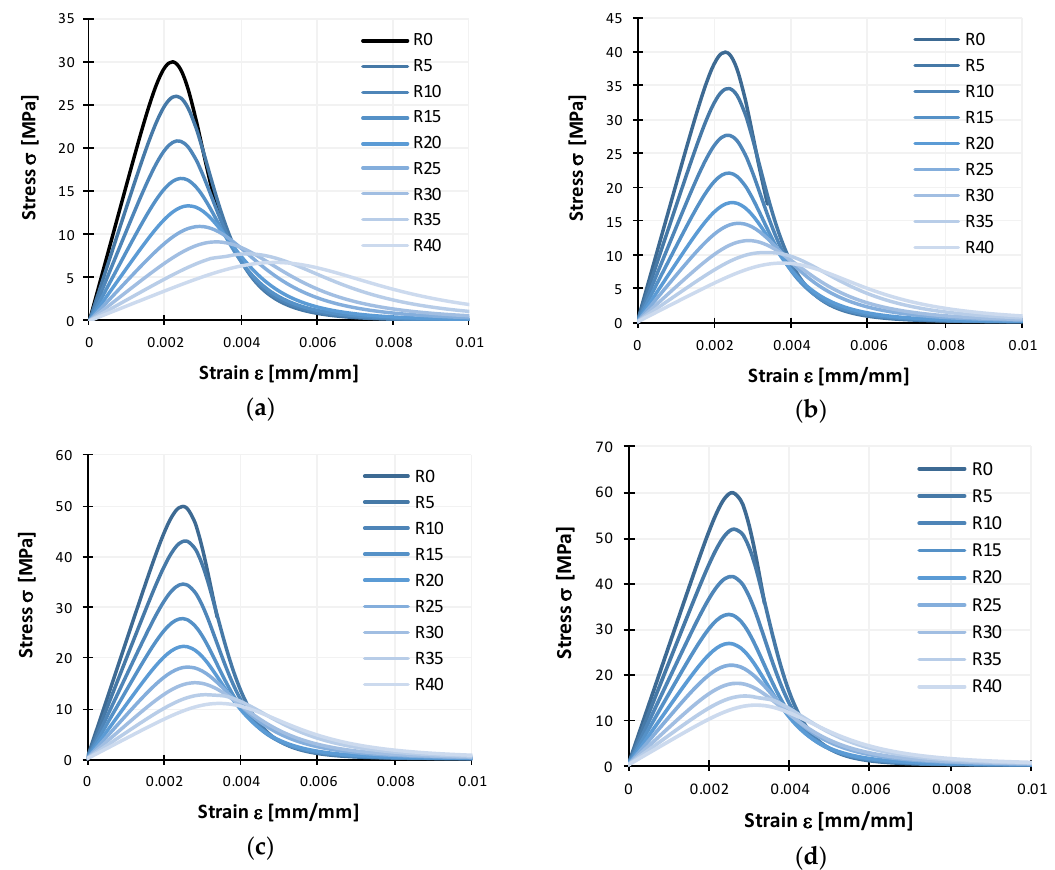
Figure 13. Comparison of stress-strain curves for normal concrete with initial compressive strength of (a) 30 MPa; (b) 40 MPa; (c) 50 MPa; (d) 60 MPa and rubber replacement up to 40%